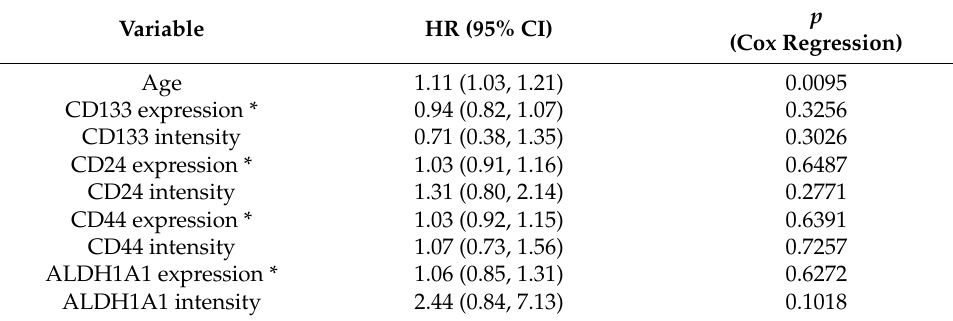
Table 5. Prognostic value of the CSC markers in